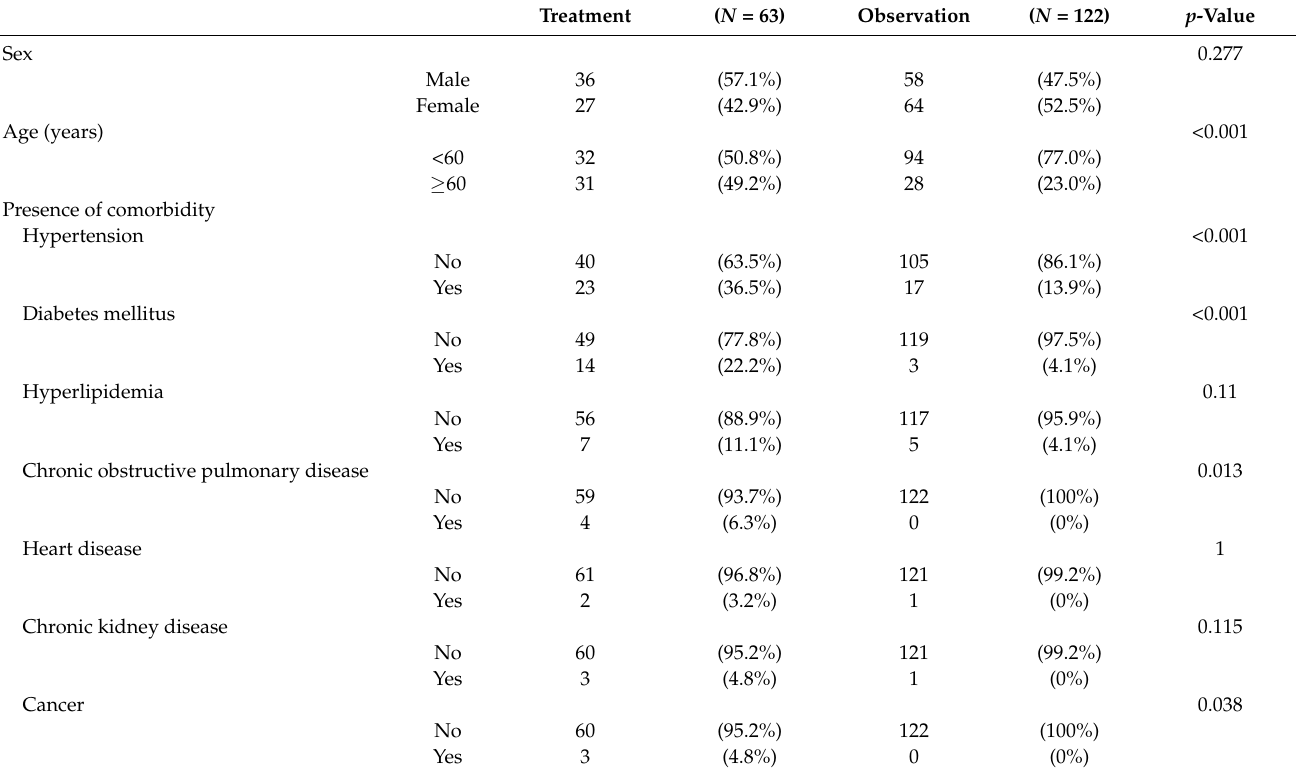
Table 2. Comparison of patients hospitalized with COVID-19 with treatment requirement and clinical observation in the fourth pandemic